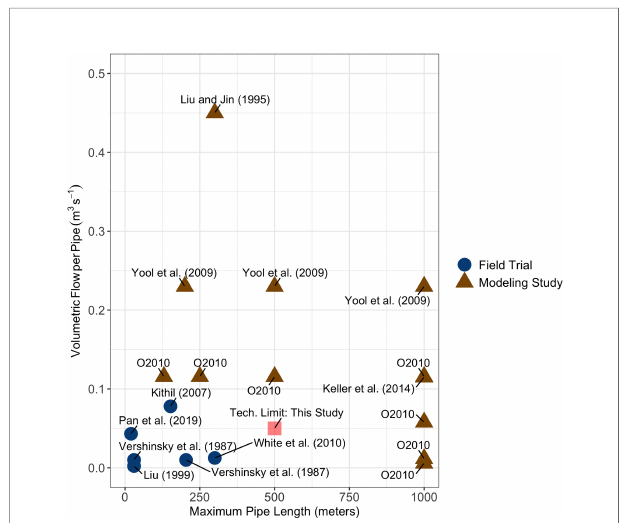
FIGURE 1 | Upwelling pipe volumetric fl ow rates and maximum depths for fi eld tests (blue circles) and modeling studies (brown triangles). The label ‘ O2010 ’ refers to Oschlies et al. (2010). Volumetric fl ow rates for Yool et al. (2009); Keller et al. (2014), and Oschlies et al. (2010) were calculated from the reported upwelling velocities in each study and assuming an areal density of pipes of one pipe per square kilometer as discussed in Oschlies et al. (2010). The maximum depth and fl ow rate for the scenario where the depth of the upwelling pipe is limited to 500 meters is shown as a red